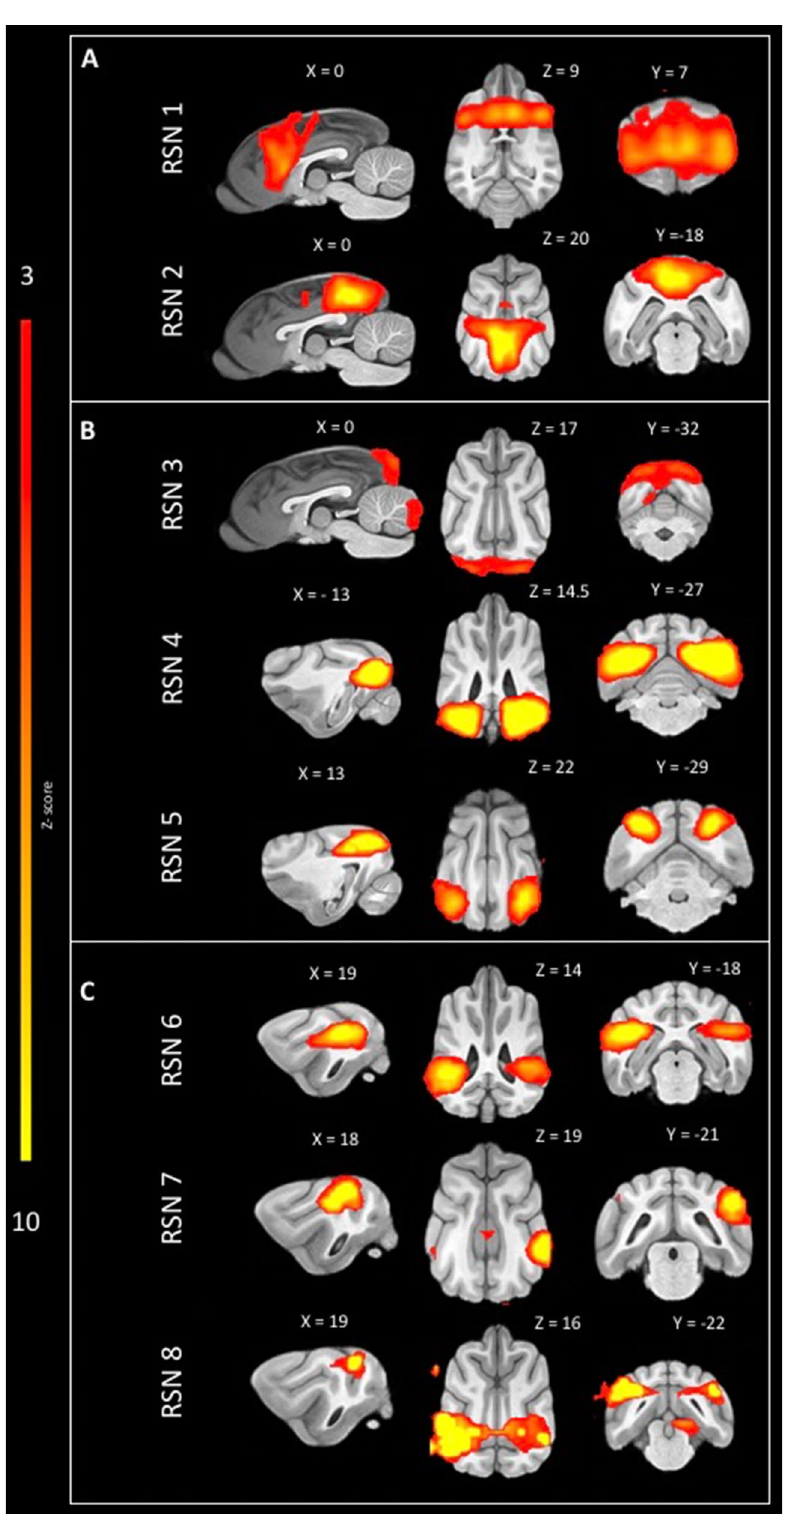
Figure 2. Sagittal, dorsal and transversal images of RSN obtained by means of group ICA of healthy control and epileptic dogs overlaid on a T1W open-source stereotactic atlas 46 . The results are reported as local false discovery rate controlled (p < 0.05) thresholded z-maps, with red-yellow color encoding using a 3 < Z-score threshold. This figure was created using FSLeyes (version 2.1 https:// fsl. fmrib. ox. ac. uk/ fsl/ fslwi ki/ FSLey es) and Microsoft Powerpoint (version 16.16.19, http:// www. micro soft.